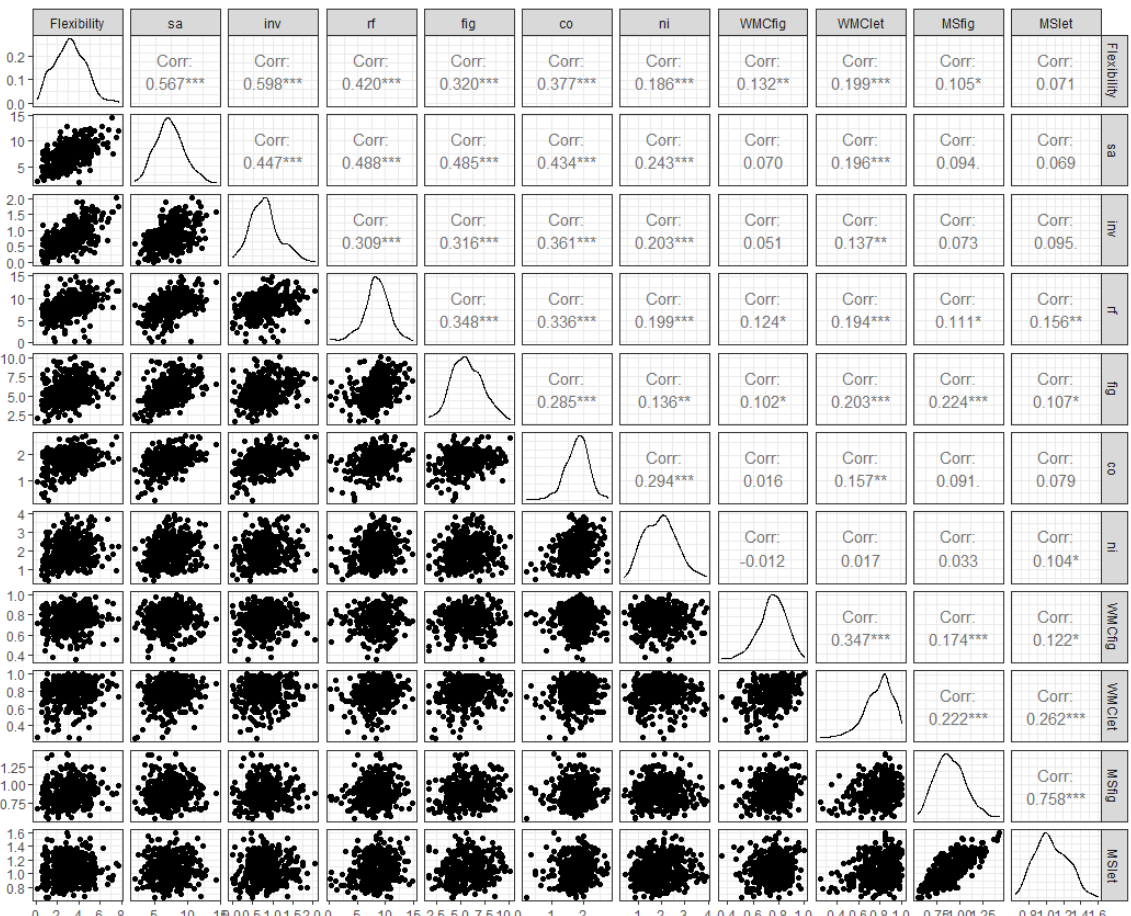
Figure 2. Correlations on a manifest level: flexibility, fluency, originality, working memory, and mental speed. Note: Statistically significant correlations are marked with * ( p < .05), ** ( p < .01), and *** ( p < .001). Fluency indicators: sa = similar attributes; inv = inventing names; rf = retrieval fluency; and fig = figural fluency. Originality indicators: co = combining objects and ni = nicknames. WMC = working memory and MS = mental speed.